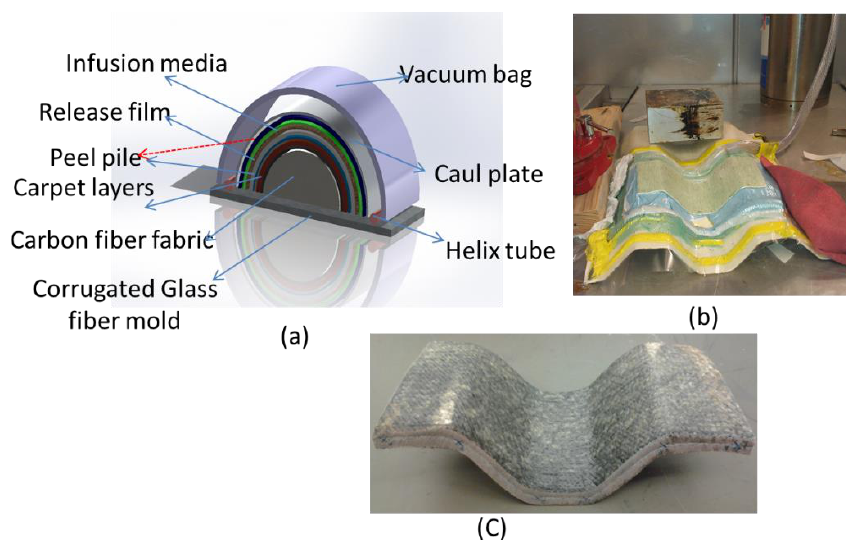
Figure 1. Vacuum assisted resin transfer molding set up for tooling fabrication ( a ) Schematic diagram, ( b ) actual VARTM in the oven, ( c ) cured composite tooling material.